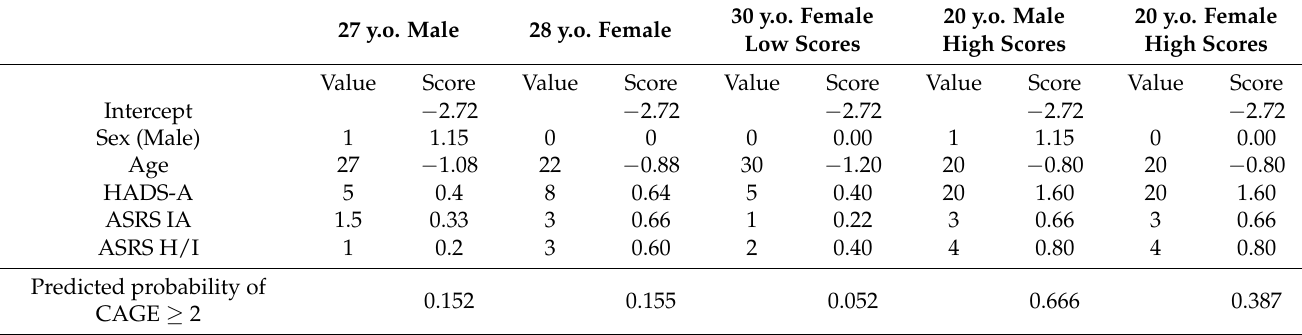
Table 4. Five hypothetical subjects with their predicted probability of having a CAGE score ≥ 2. The optimal cut -off was set at 0.153. The first two subjects approximately achieved this predicted probability.